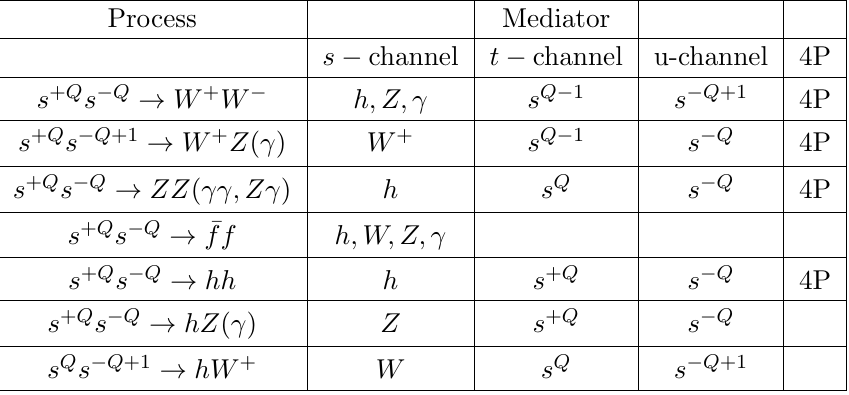
Table 1 . A complete set of process relevant to the co-annihilation of the scalar multiplet dark matter. Here, 4P represents four point interactions, while, s Q denotes the component of the DM mutliplet having charge Q